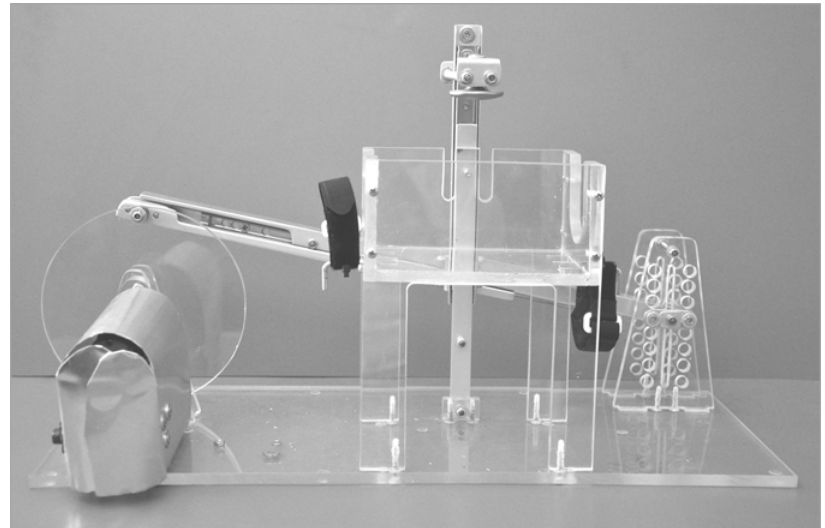
Fig 2. Electromechanical device constructed to compress the SIB under standardized